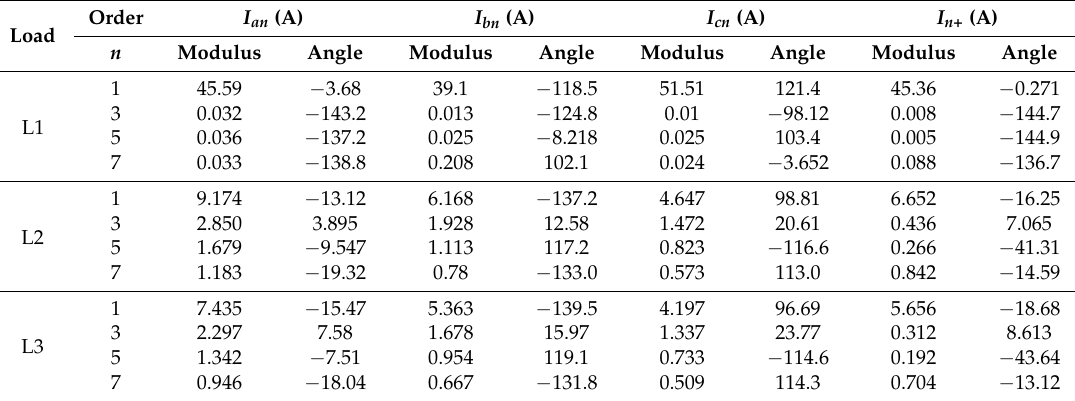
Table 3. Harmonic currents in each phase and positive-sequence harmonic currents.